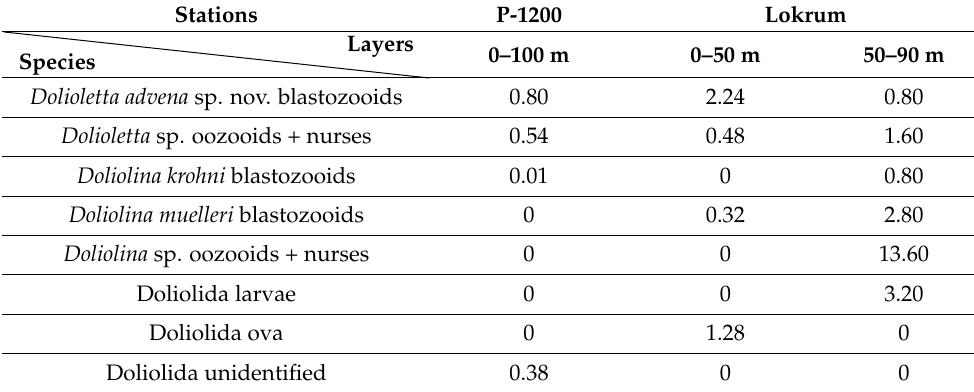
Table 2. Abundance and species composition of doliolids at stations P-1200 (on 23 August 2021) and Lokrum (on 18 August 2021). Abundances are expressed as number of individuals per m 3 .